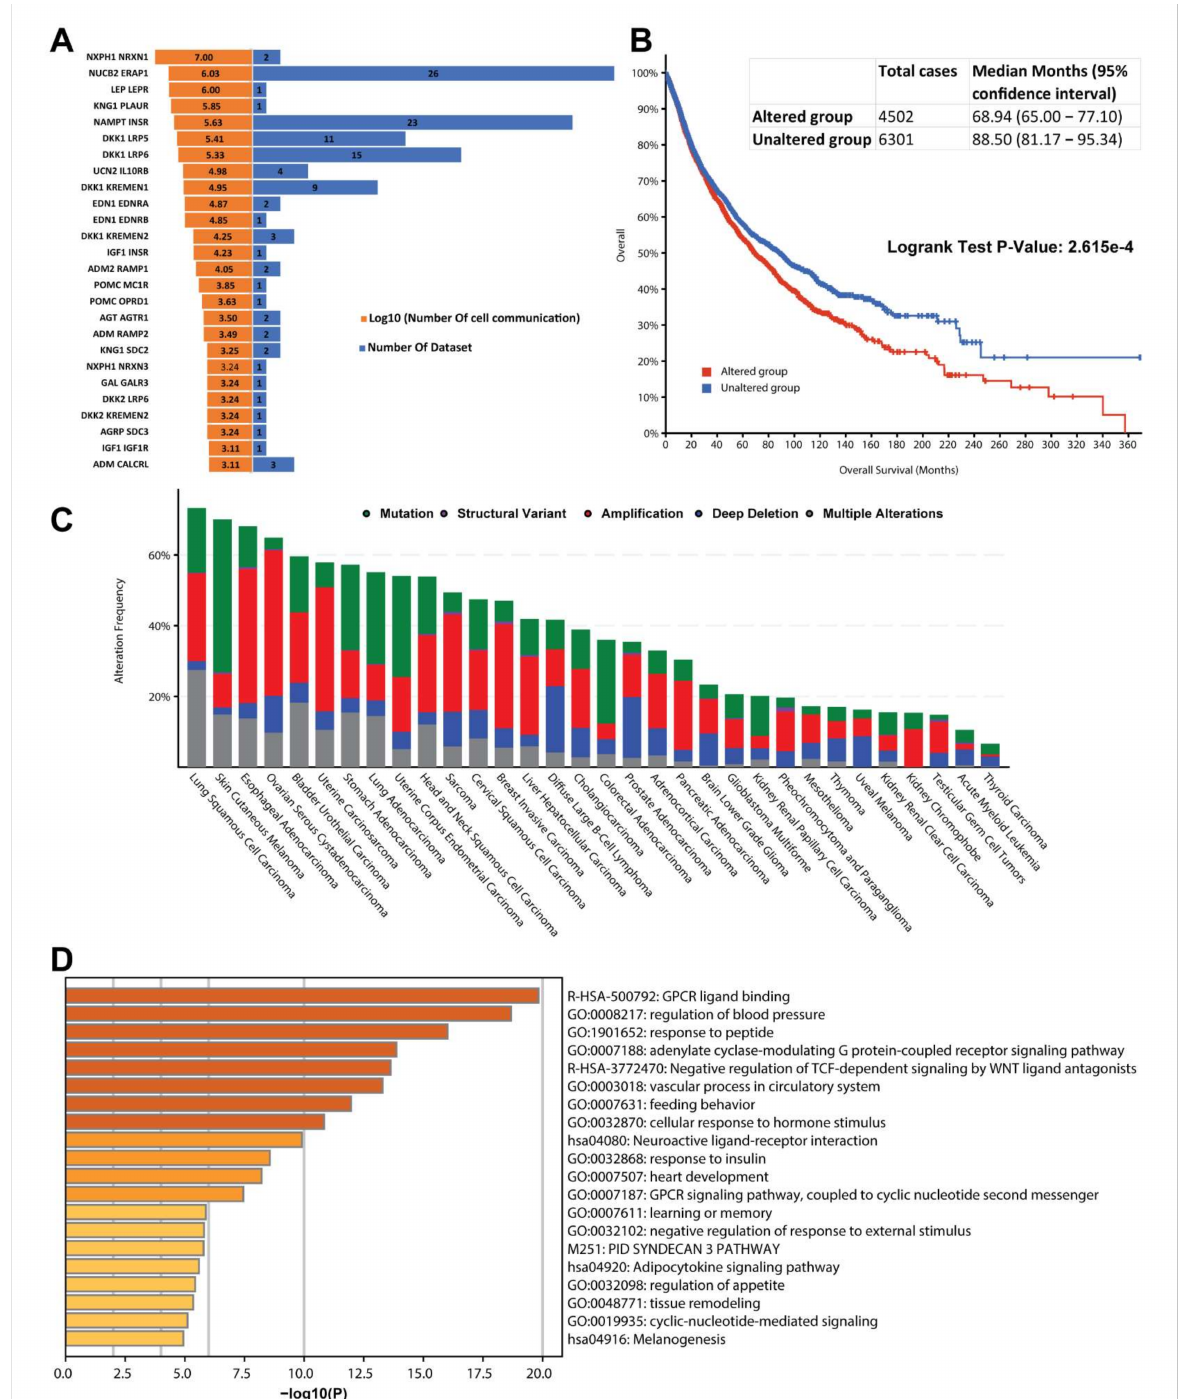
Figure 3. The functional feature of stably expressed neuropeptide-receptor genes. ( A ) The butterfly chart depicts the number of cell communications and datasets associated with the 26 stably expressed neuropeptide-receptor pairs. ( B ) The Kaplan–Meier curves show the overall survival months for patients with specific mutations (red) and no mutations (blue) in each of the 39 genes. ( C ) The vertical bar chart depicts the frequency of mutations in 32 TCGA cancer types. ( D ) The functional cluster representatives for the 39 genes are summarized in the bar plot. The x-axis indicates the log of corrected p -value calculated by the hypergeometric test. The darker color represents more significant p